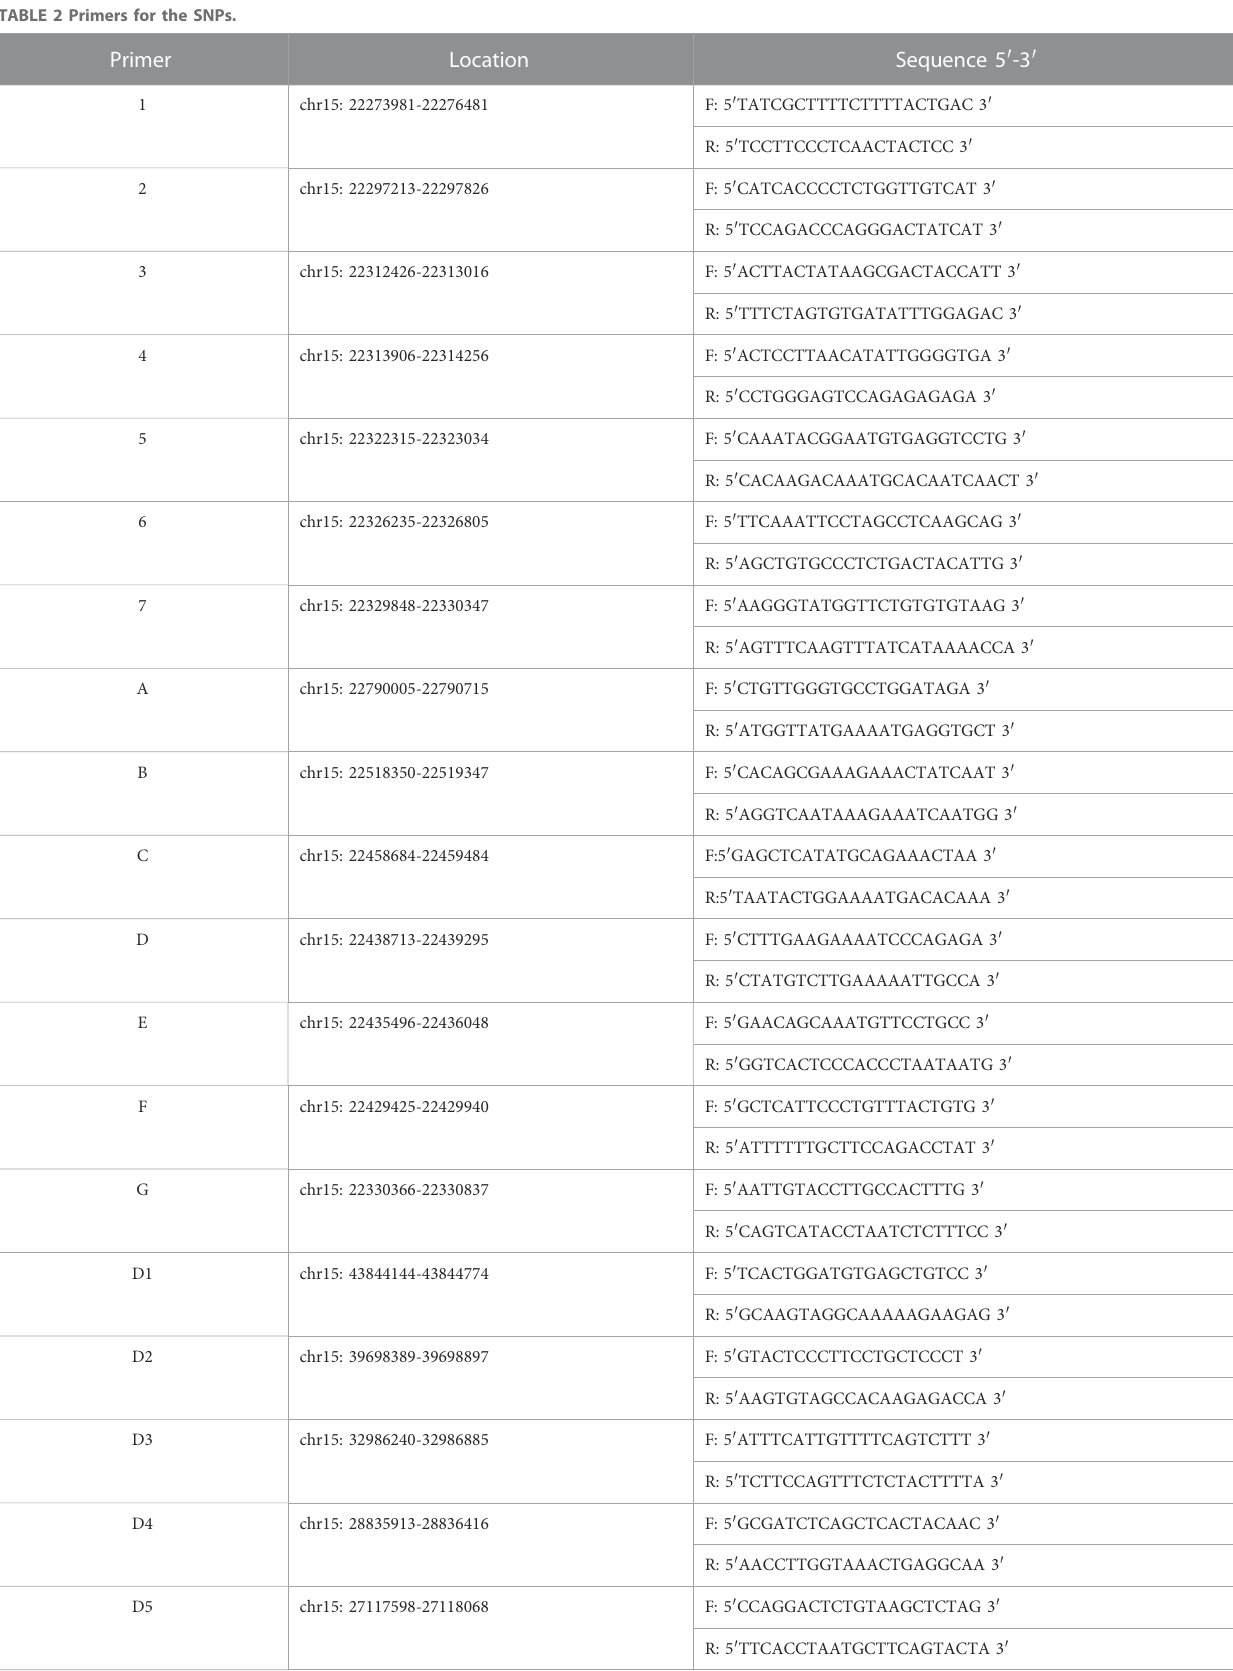
TABLE 2 Primers for the